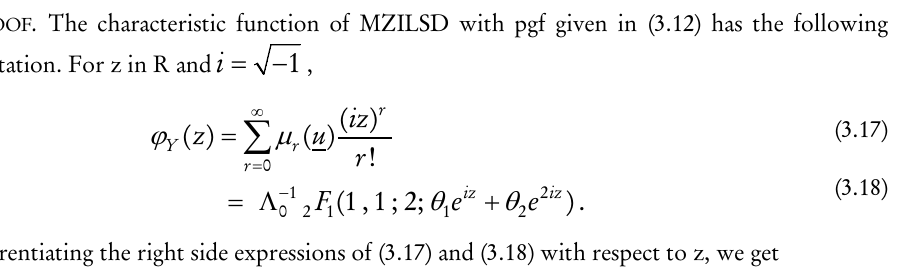
On differentiating the right side expressions of (3.17) and (3.18) with respect to z, we